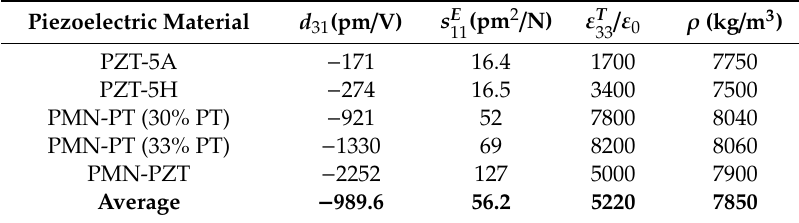
Table 3. Properties of interest for various ceramics and single crystals